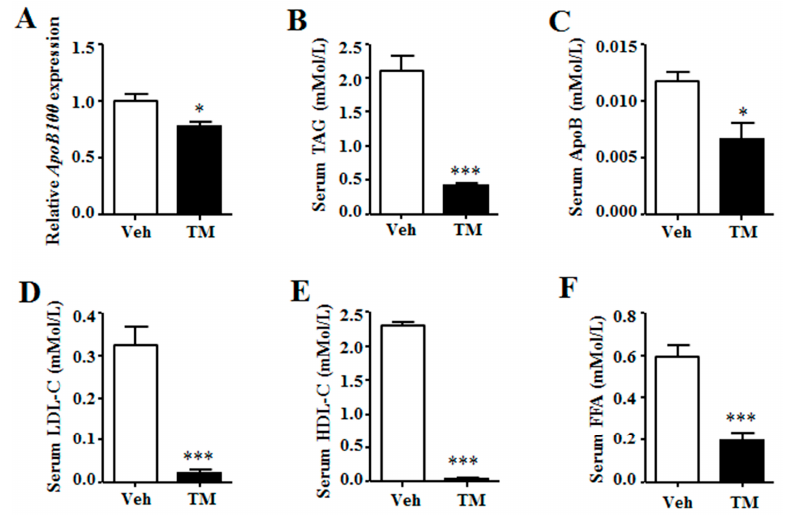
Figure 5. Tunicamycin impaired hepatic lipoprotein secretion. ( A ) Gene expression of ApoB100 in the liver; ( B ) Serum levels of triglyceride; ( C ) Serum levels of apolipoprotein B; ( D ) Serum levels of low-density lipoprotein cholesterol; ( E ) Serum levels of high-density lipoprotein cholesterol; ( F ) Serum levels of free fatty acid. N = 6 per group. Veh, vehcle; TM, tunicamycin. * p < 0.05, *** p < 0.001 TM vs. Veh.